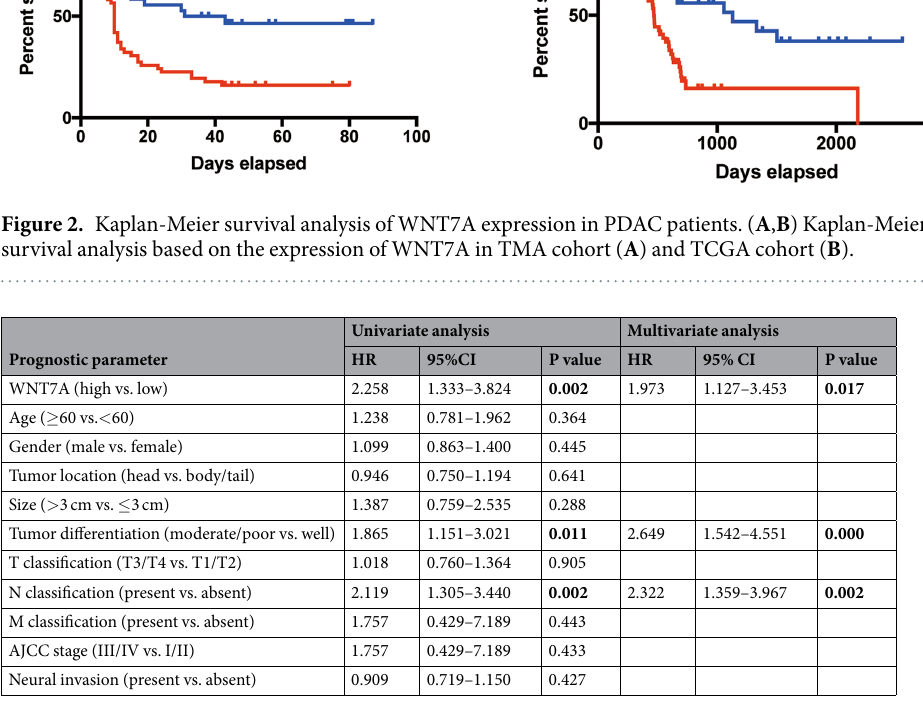
Table 2. Univariate and multivariate analyses of prognosis factors for survival in PDAC patients. HR: Hazard ratio; CI: confidence interval. The bold number represents the p-values with significant